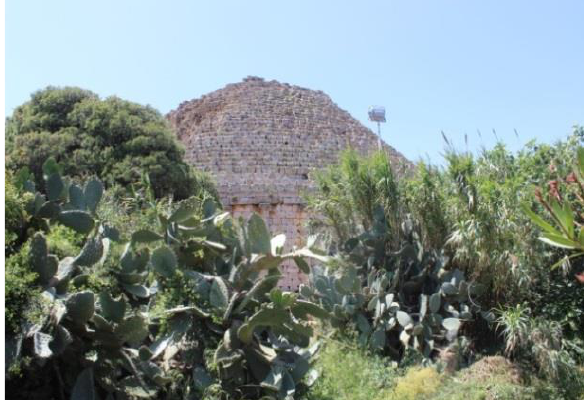
Figure 7. The natural environment around the Mausoleum,